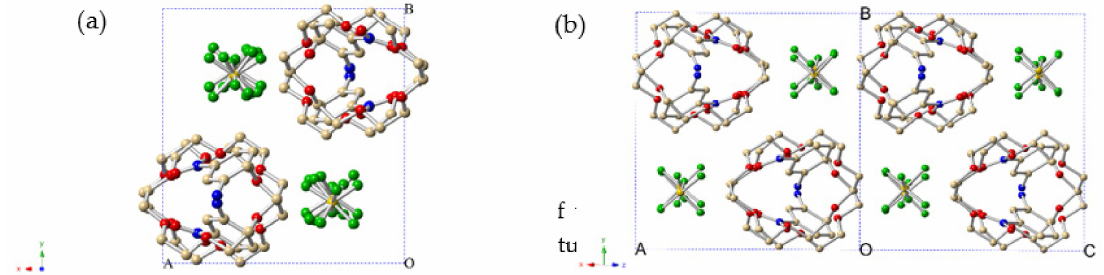
Figure 4. View of the self-assembly packing of the (3-nitroanilinium)(18-crown) cation and PF 6 −